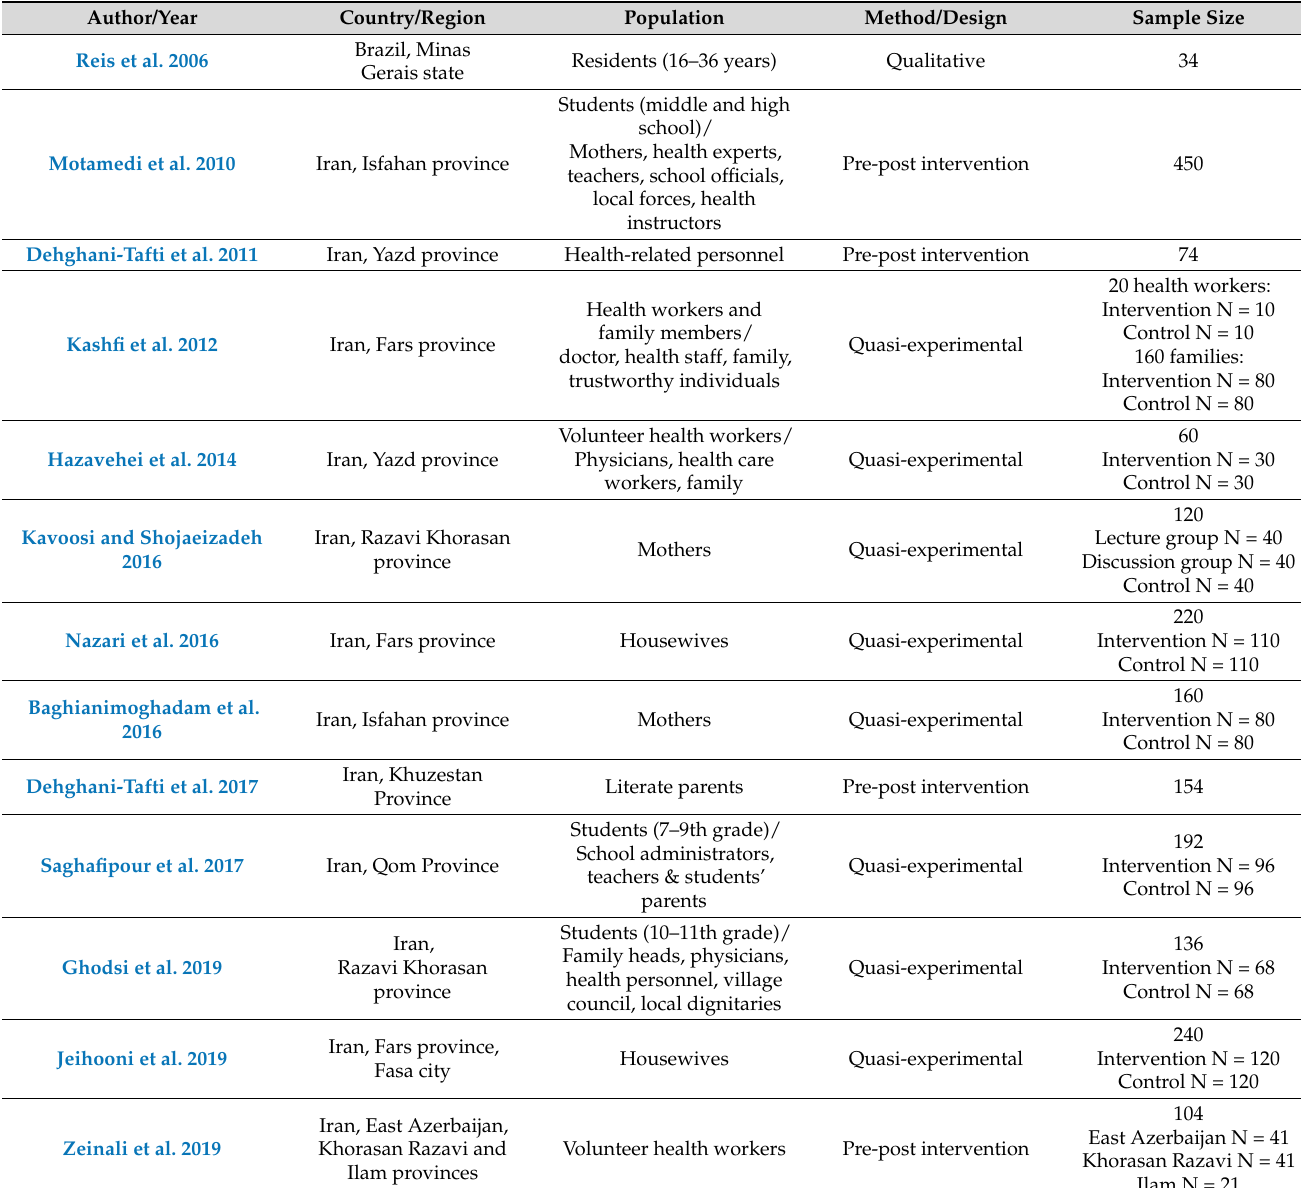
Table 2. Characteristics of included